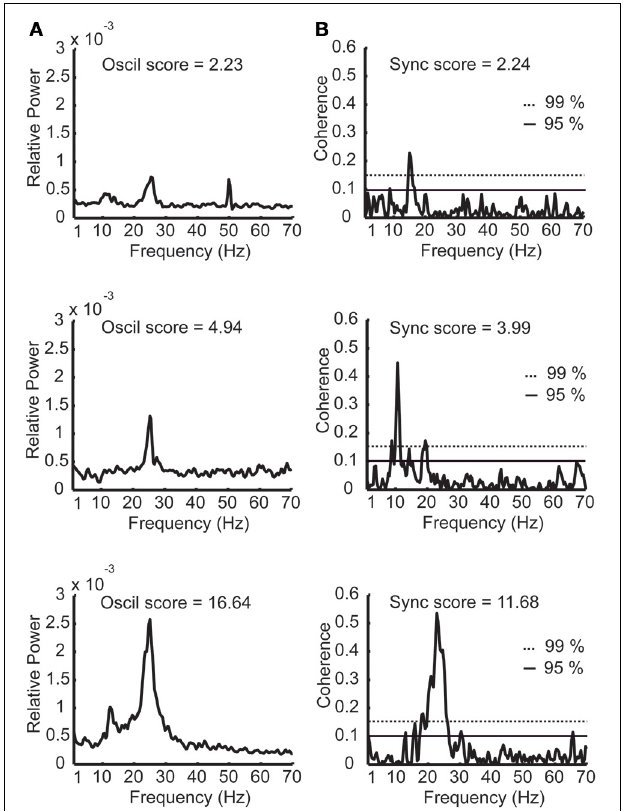
FIGURE 3 | Oscillatory activity in the STN DLOR and VMNR. Average power spectra of STN activity of DLOR (A) and VMNR (B) recordings. The shaded areas represent the standard error of the mean (SEM) of the spectrum function for each population. N sites is the number of sites averaged. (C,D) Distribution of the oscil scores in the DLOR and the VMNR recordings. Note the different scales of the Y -axes. Oscil scores below zero and above 20 ( n = 68 and 153 out 4780) are appended to the first and last bin respectively to enhance visualization of the results.